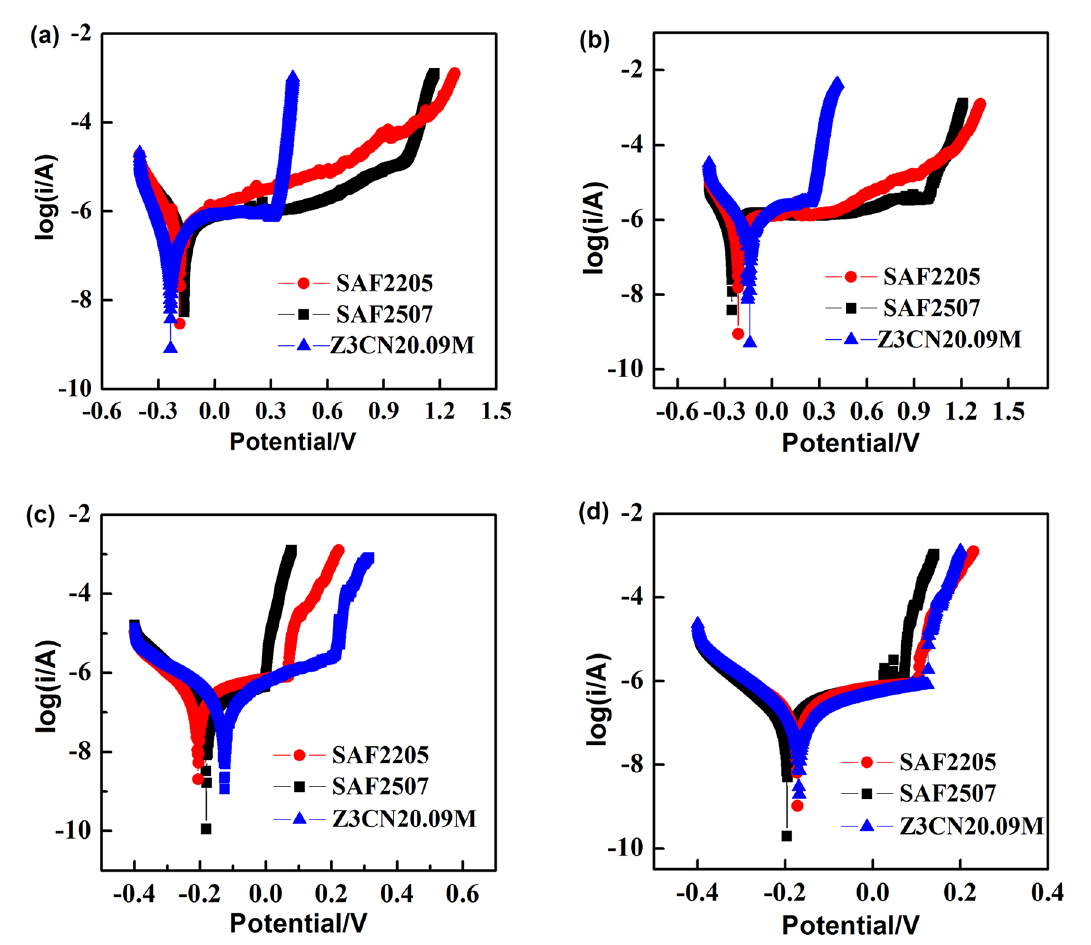
Figure 5. Polarisation curves of DSS specimens aged at different temperature (a) solid solution, (b) 350℃, (c) 450℃, (d) 500℃